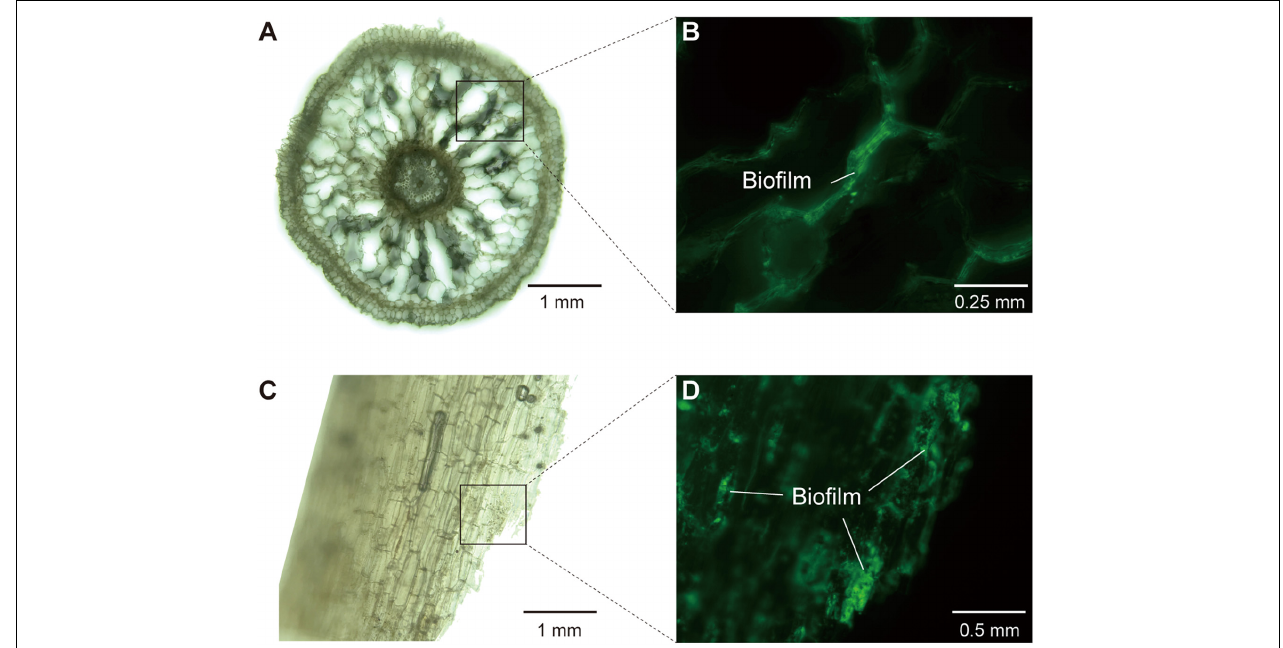
FIGURE 5 | The structure of mangrove roots and the detection of biofilm in root interior under hybrid microscope. (A,B) The images of longitudinal section of mangrove roots ( × 10 and × 20 magnification, respectively). (C,D) The images of transverse section of mangrove roots ( × 10 and × 40 magnification, respectively). (A,C) Were in brightfield, whereas (B,D) were in fluorescence field (488 nm, Mercury Free LED) with extracellular polysaccharides in biofilm being stained and glowing green light.